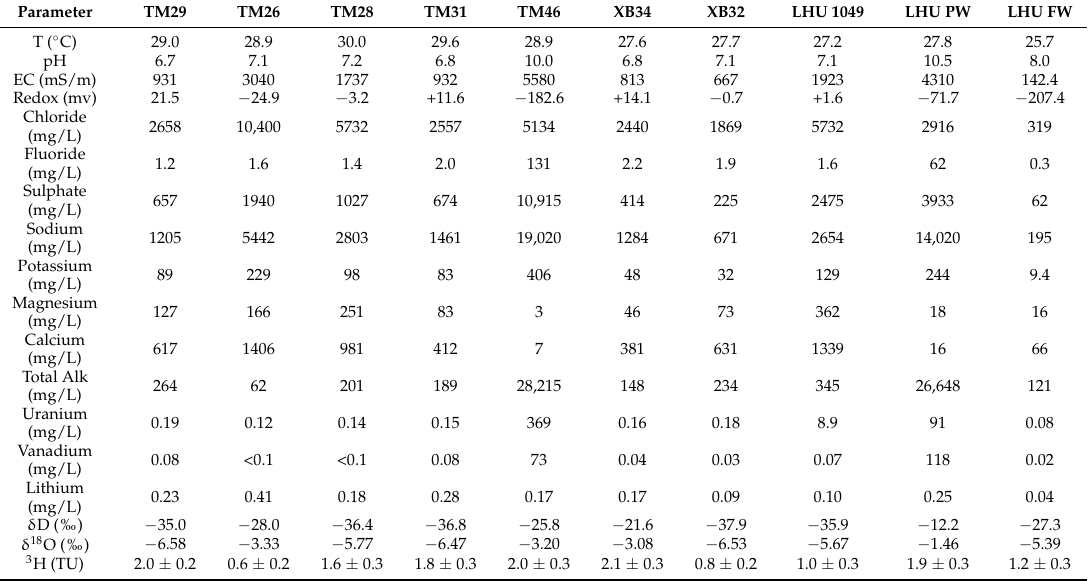
Table 2. Analytical results from the Langerheinrich Uranium